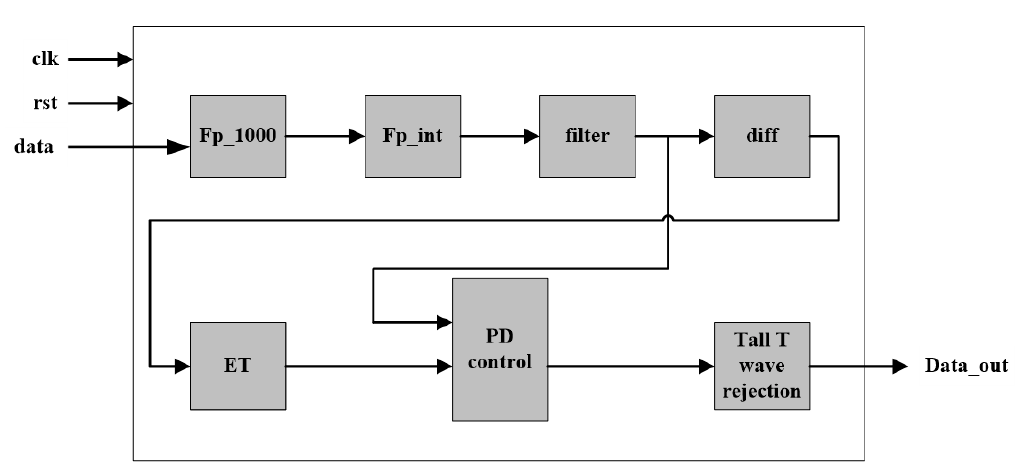
Figure 8. Architecture of the hardware implementation of the proposed